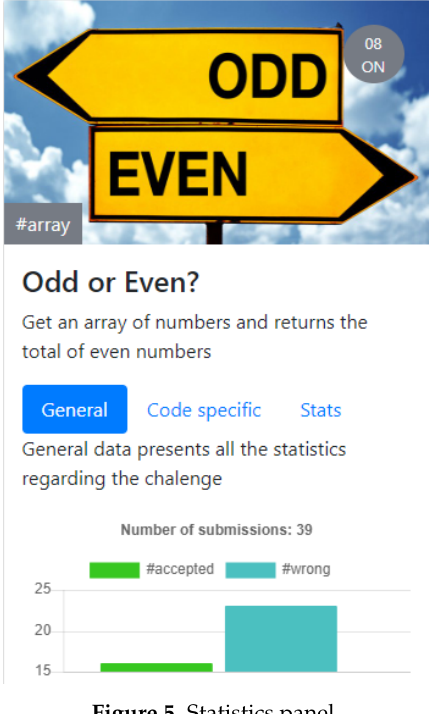
Figure 5. Statistics